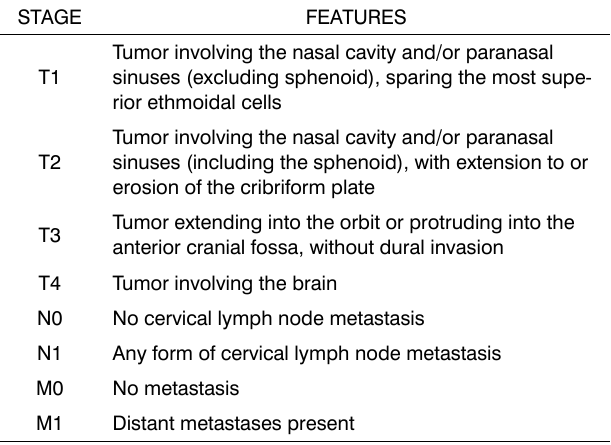
Table 2. Staging system according to Dulguerov et